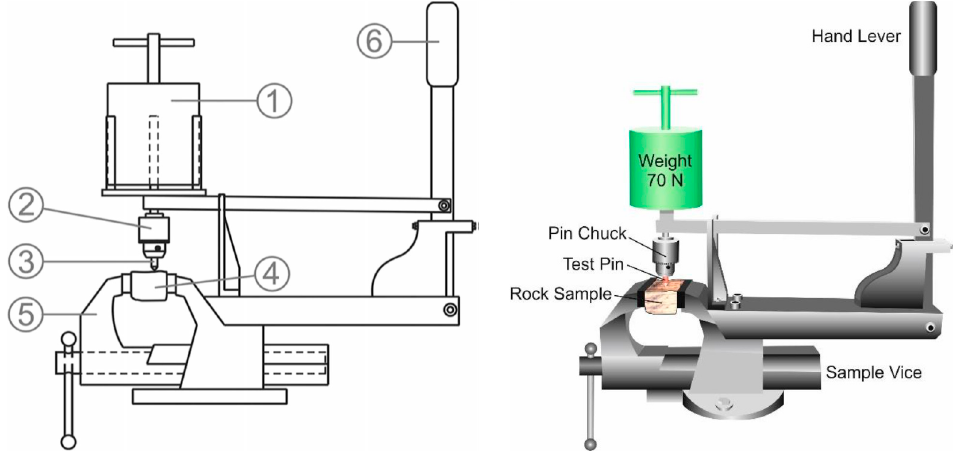
Figure 3. Setup of a first ‐ generation Cerchar testing device [7]. (1) Weight, (2) pin chuck, (3) steel pin, (4) specimen, (5) vice, and (6) hand lever [1].